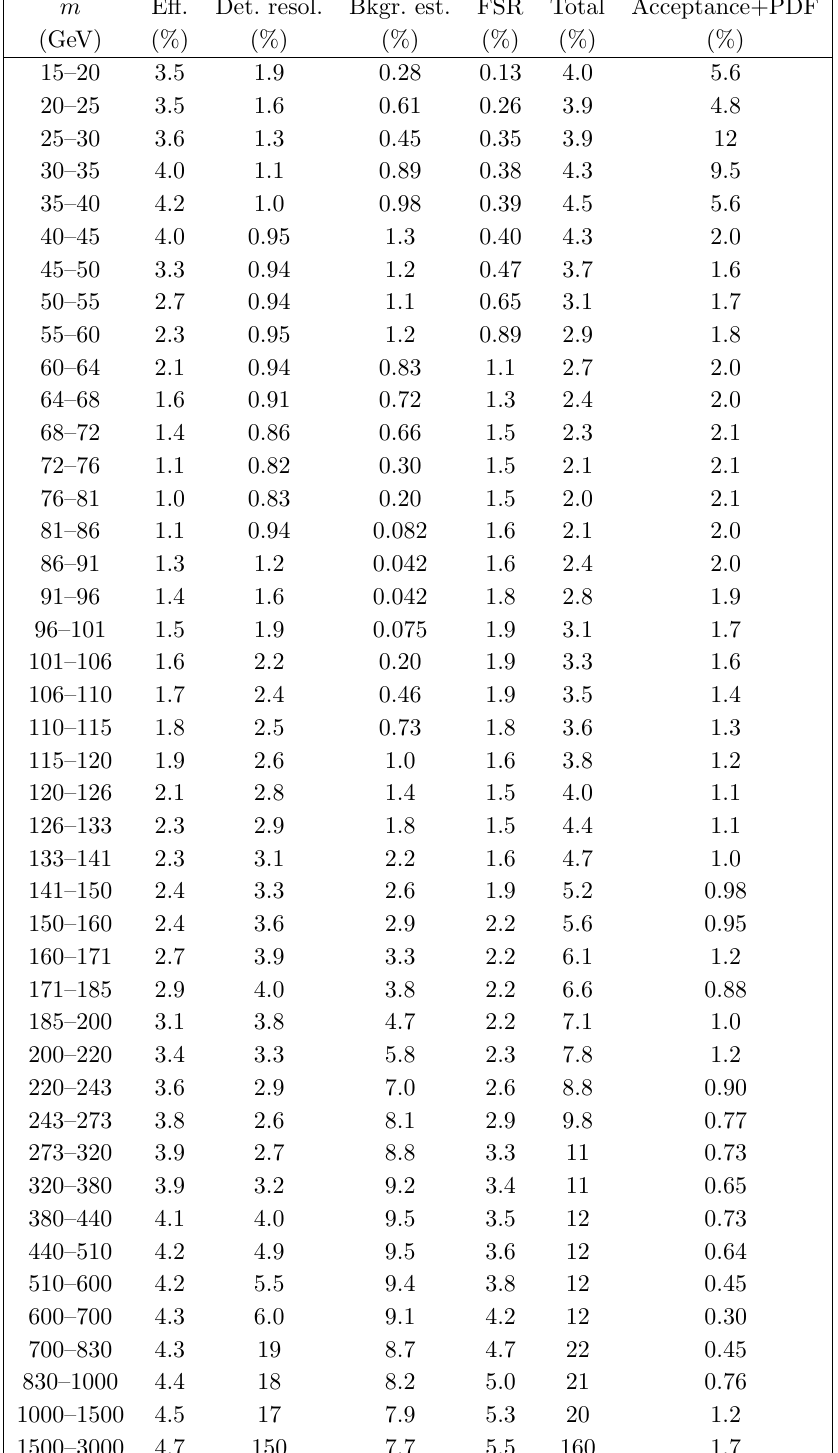
Table 1 . Summary of the systematic uncertainties (%) for the d (cid:27)= d m (pb/GeV) measurement in the dimuon channel. The column labelled \Total" corresponds to the quadratic sum of all the experimental sources, except for that